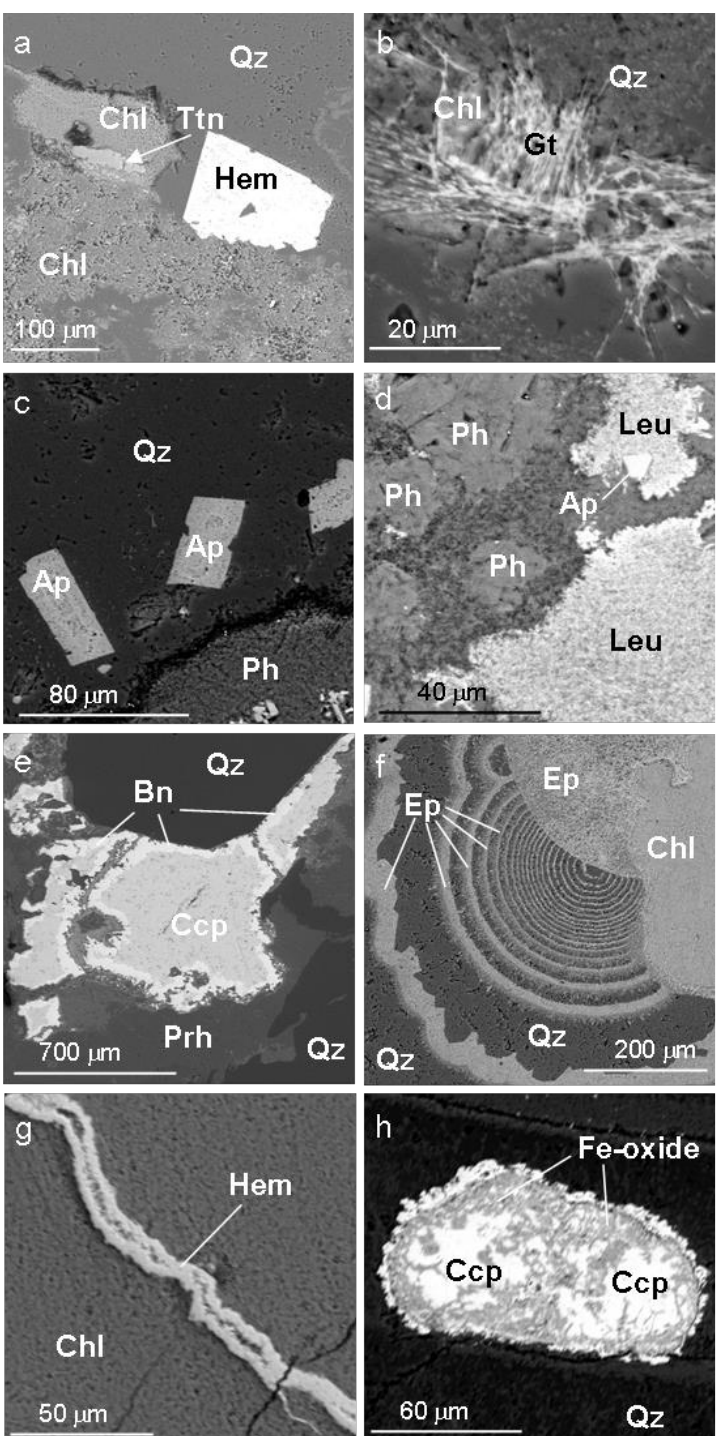
Figure 8. BSE images of microinclusions in Onega agates: ( a ) hematite (Hem) crystal in association with chlorite (Chl), quartz (Qz), and titanite (Ttn); ( b ) needle-like crystals of goethite (Gt) surrounded by silica; ( c ) prismatic apatite (Ap) grains and phengite (Ph) in outer chalcedony zone of agate; ( d ) flacked leucoxene (Leu) and phengite enclosed by chlorite; ( e ) chalcopyrite (Ccp) embedded with bornite (Bn) surrounded by quartz and prehnite (Prh); ( f ) epidote pseudomorphs after banded silica; ( g ) chlorite fissure filled by hematite; ( h ) patchy inclusion of chalcopyrite with Fe-oxide replacement zones.